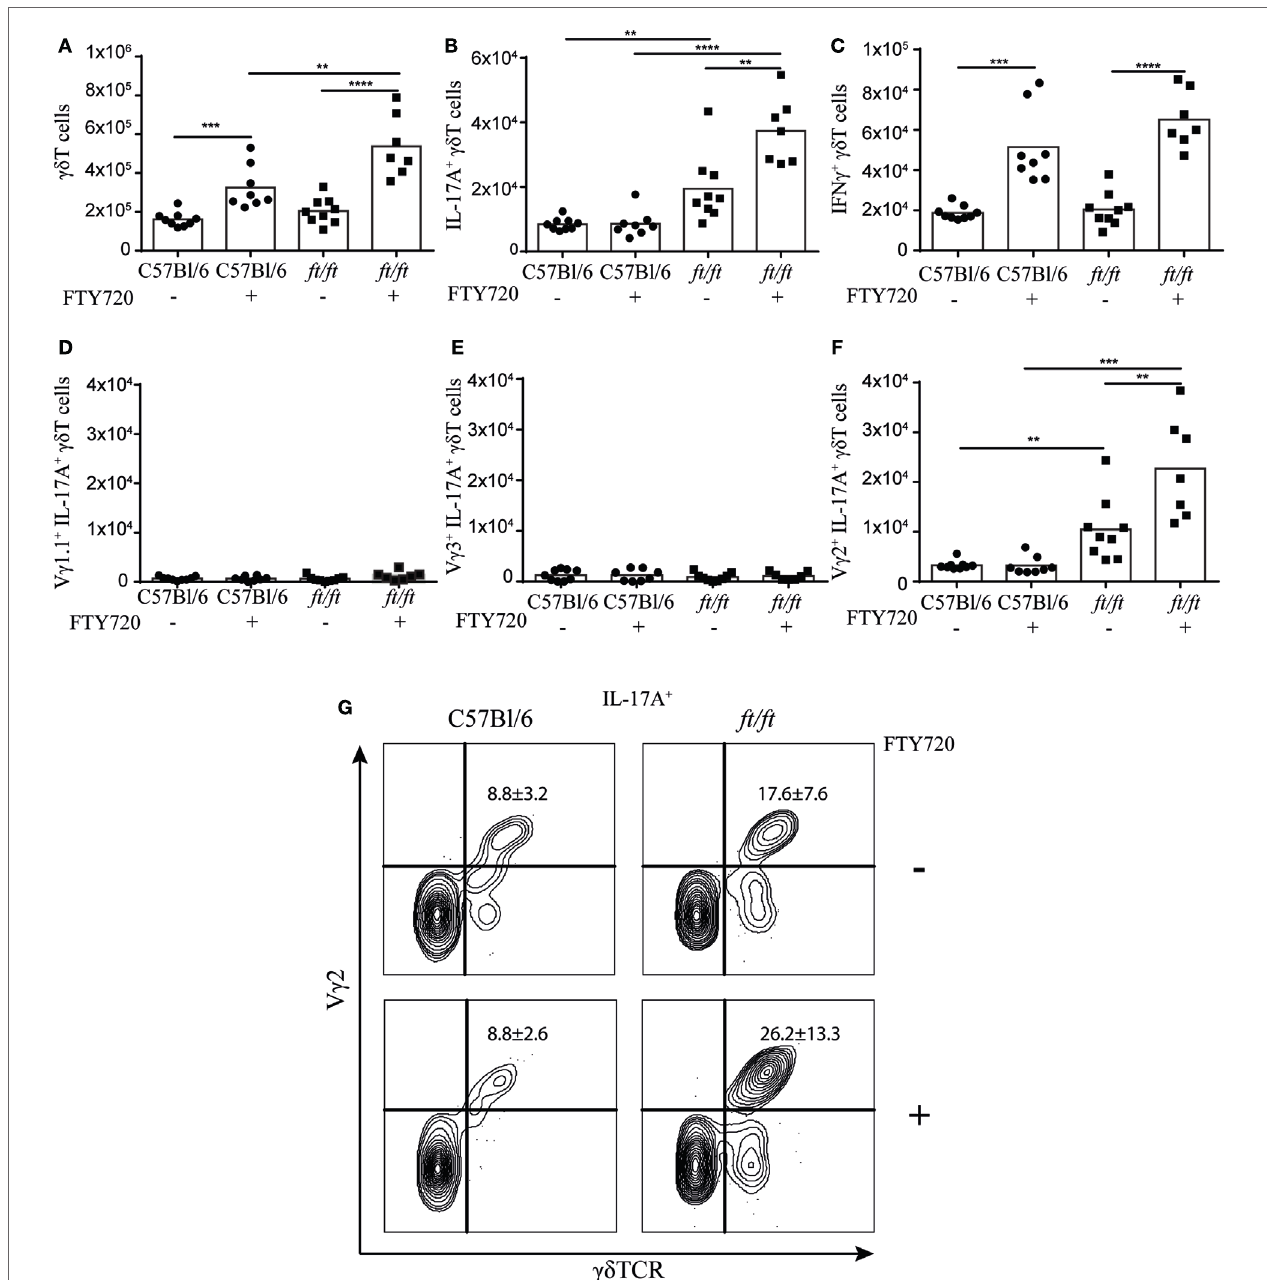
FigUre 4 | ft/ft mice accumulate γδ T17 cells in the adult thymus. Numbers of γδ TCR cells and γδ TCR subsets in the thymus of 8–12 weeks old ft/ft and C57BL/6 mice treated with FTY720 or untreated. Single-cell suspensions were stained with anti-TCR γδ , -TCR β , -IL-17A, –IFN- γ . -V γ 1.1, -V γ 2, and -V γ 3. Percentages of each population were multiplied with the cell count of the parent gate to get the numbers presented. (a) Numbers of γδ TCR cells. (B) Numbers of IL-17A + γδ TCR cells. (c) Numbers of IFN- γ + γδ TCR cells. (D) Numbers of V γ 1.1 + IL-17A + γδ TCR cells. (e) Numbers of V γ 3 + IL-17A + γδ TCR cells. (F,g) Numbers and percentage of V γ 2 + IL-17A + γδ TCR